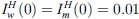
Effect of spatial structure on epidemiology and evolution in the model.The top figures (A) show simulation results for the density of susceptible (dashed line) and infected hosts (full line) for different level of mixing (left: no mixing (g
H = g
P = 0), middle: intermediate (g
H = g
P = 0.5), right: full mixing (g
H = g
P = 1)). The figures in the middle (B) show simulation results for the change in mutant frequency in the total pathogen population (black), in the horizontally infected hosts (red) or in vertically infected hosts (blue) for different levels of mixing. The figures at the bottom (C) indicate the values of the different components of the selection coefficient identified in Eq (1): the horizontal transmission term (red), the vertical transmission component (blue) and the sum of the previous two terms (black) and the magnitude of the cost of virulence (dashed black). Note that the global mutant frequency increases only when the sum of the transmission terms (full black line) is higher than the cost of virulence (dashed line). Our simulations are the result of the numerical integration of the deterministic approximation of the full spatial model, using Improved Pair Approximation (IPA; [31]) with parameters ϕ = 1/6 and θ = 2/5, which correspond to a triangular lattice (each site has 6 neighbours, see [31] for details). Parameters: α
w = 0.1, α
m = 1, β
w = 2, β
m = 3.5, δ = 0.99, d = 0.01. Initial conditions: S(0) = 0.8, IwH(0)=ImH(0)=0.01,IwV(0)=ImV(0)=10−5.